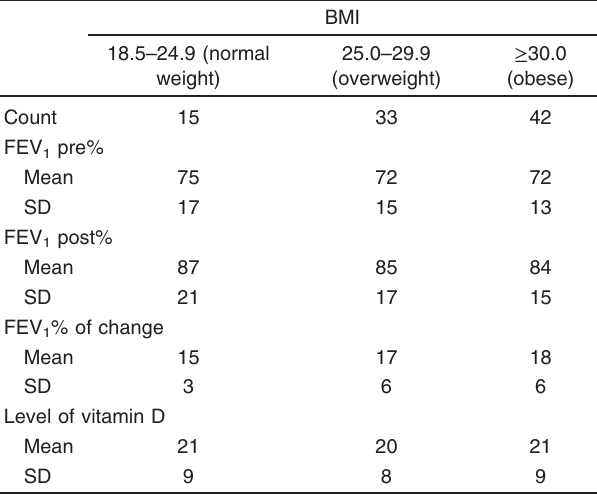
Table 5 The correlation between the vitamin D level and the severity of asthma for the